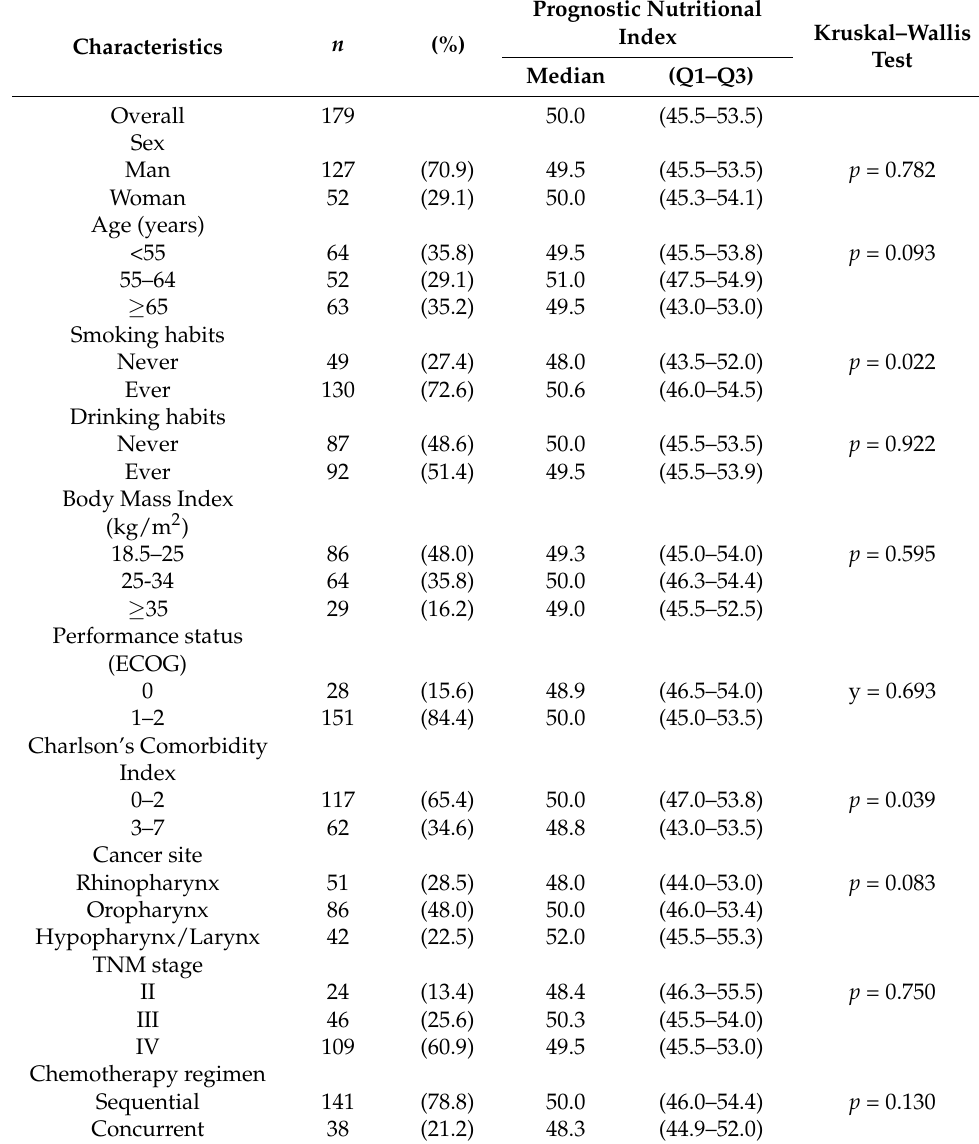
Table 1. Prognostic Nutritional Index according to socio-demographic and clinical characteristics.